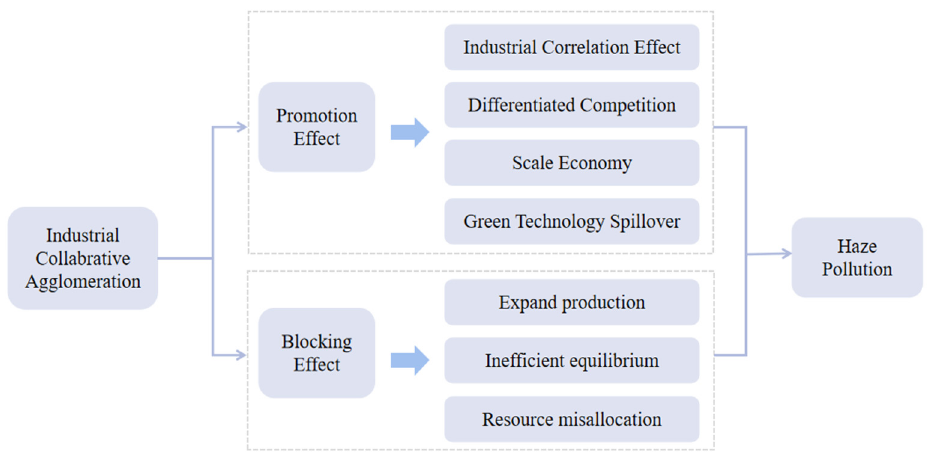
Figure 1. Mechanism for industrial co-agglomeration to affect haze pollution.